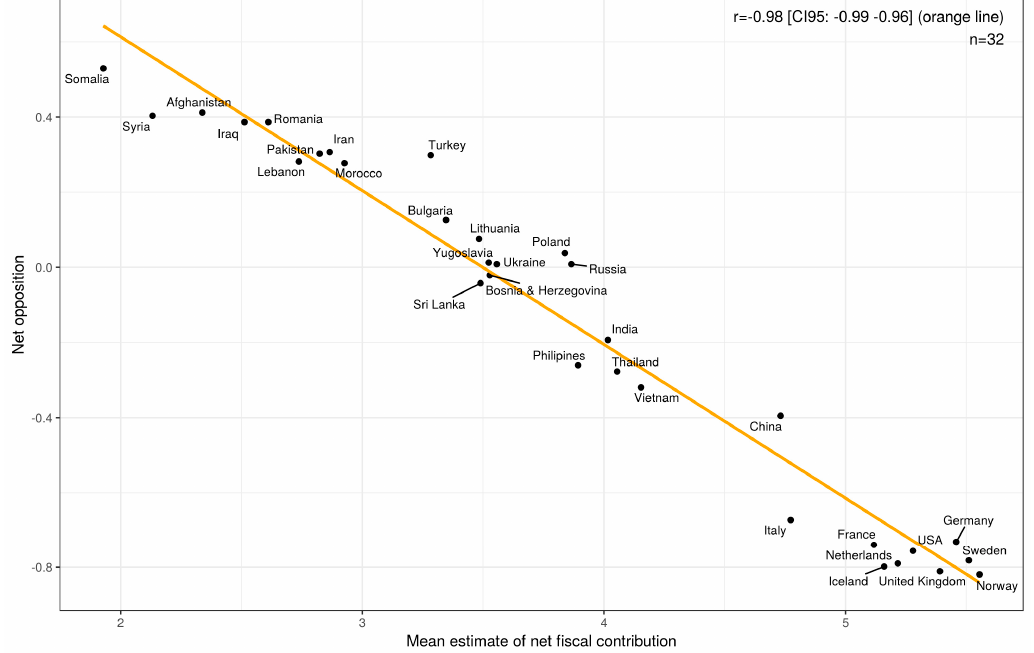
Figure 4. Scatterplot of net opposition and estimated net fiscal contribution (Pearson